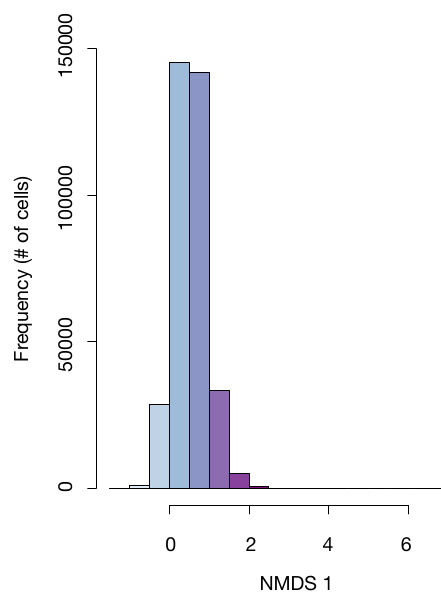
Figure 6. Distribution of the nMDS-1 predicted values.